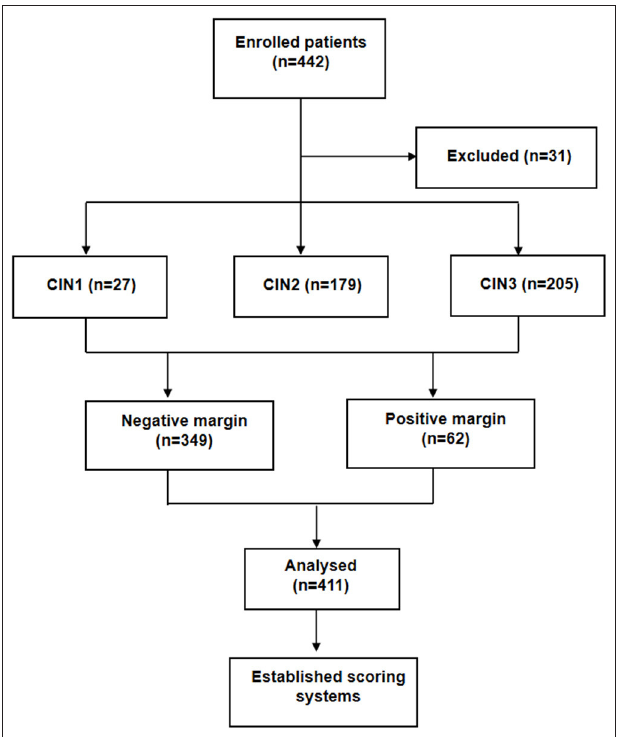
FIGURE 1 | Research roadmap and basic information.